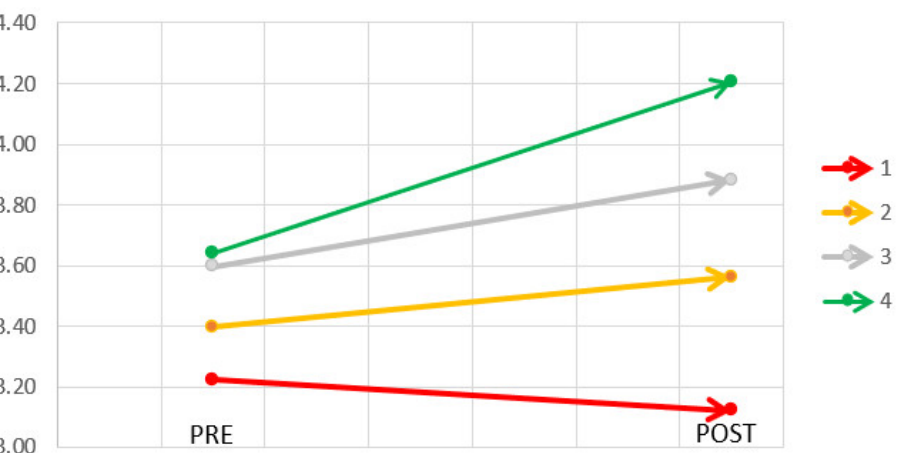
Figure 8. Pre-instruction vs . post-instruction average scores of the views about quantum technologies (VAQT) instrument (general epistemic views) according to the performance in the QTI for four groups (see Table 3).